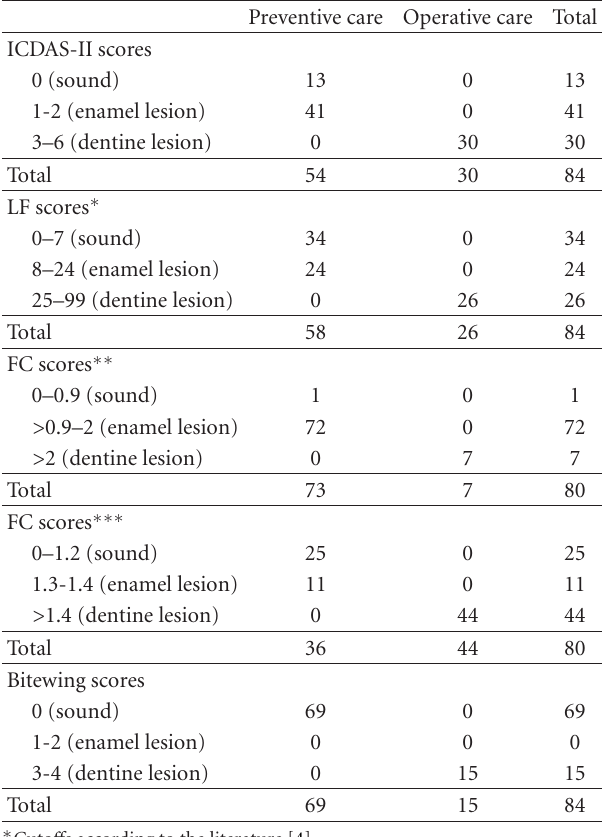
Table 5: Cross tables showing the relationship between the treatment decisions when di ff erent methods were